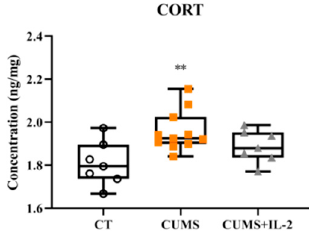
Figure 6. IL-2 attenuated the increased expression of microglia M1 phenotype marker Iba-1 ( A